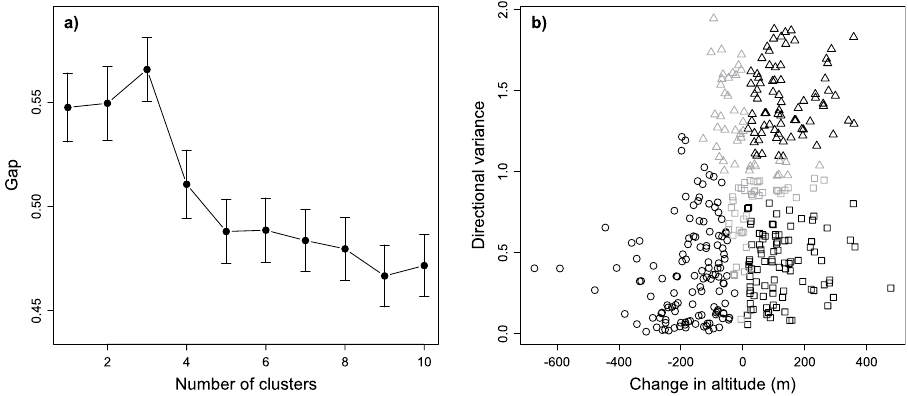
Figure 2. ( a ) Gap statistic as a function of the number of clusters. Clusters were built from the variables elevation change and directional variance with the K-means algorithm. Error bars represent standard error. The optimal number of clusters for this dataset stands on three clusters, i.e., the first maximum that does not overlap with the standard error of earlier observations (see Maechler et al . 58 ). ( b ) Distribution of track segments according their elevation change and directional variance values, and classified in three clusters (different symbols) as defined in ( a ). Circles, triangles and squares represent, gliding, circular soaring and linear soaring track segments, respectively. Grey observations, placed at the boundaries of clusters, were excluded from further analysis in order to define flight modes more distinctively. These were gliding segments with elevation change above − 15 m, circular and linear soaring segments with elevation change below 15 m (these representing 15% of all track segments), and 15% of the remaining segments that stand at the boundary between circular and linear soaring regarding directional variance.